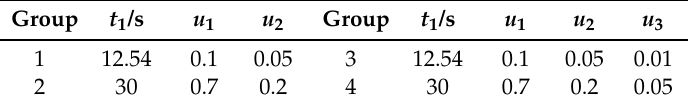
Table 2. The initial values for undetermined parameters.